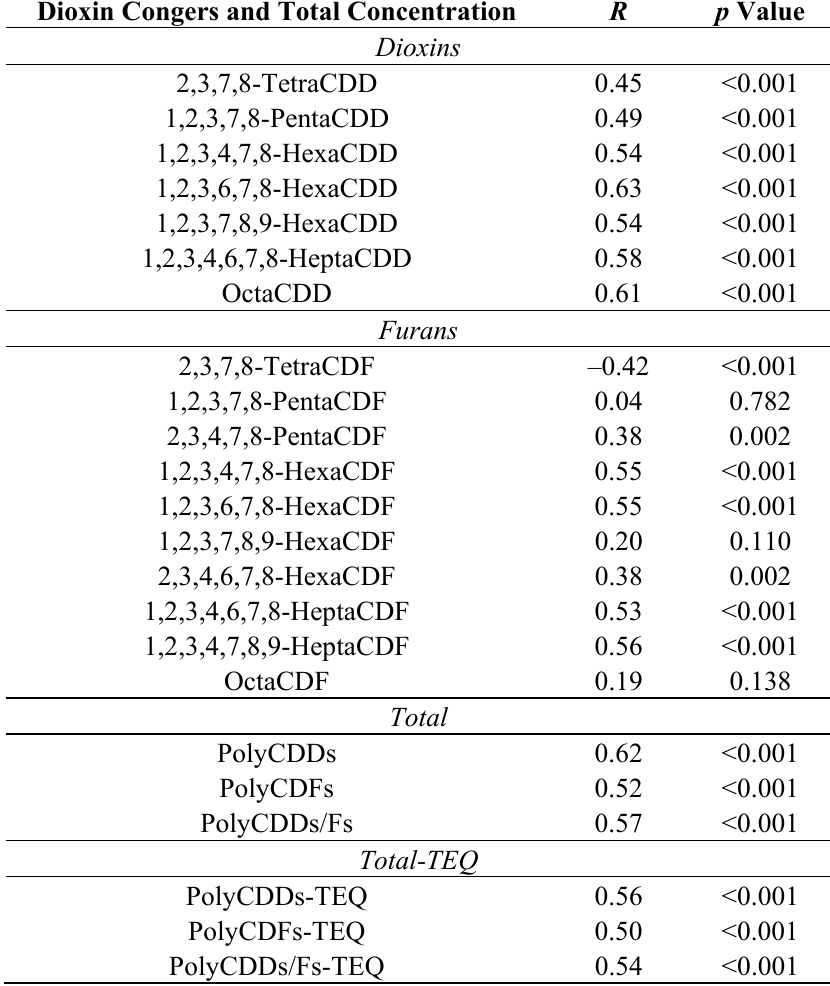
Table 3. Relationship between SCE and dioxin congeners and total concentrations in breast milk ( n =